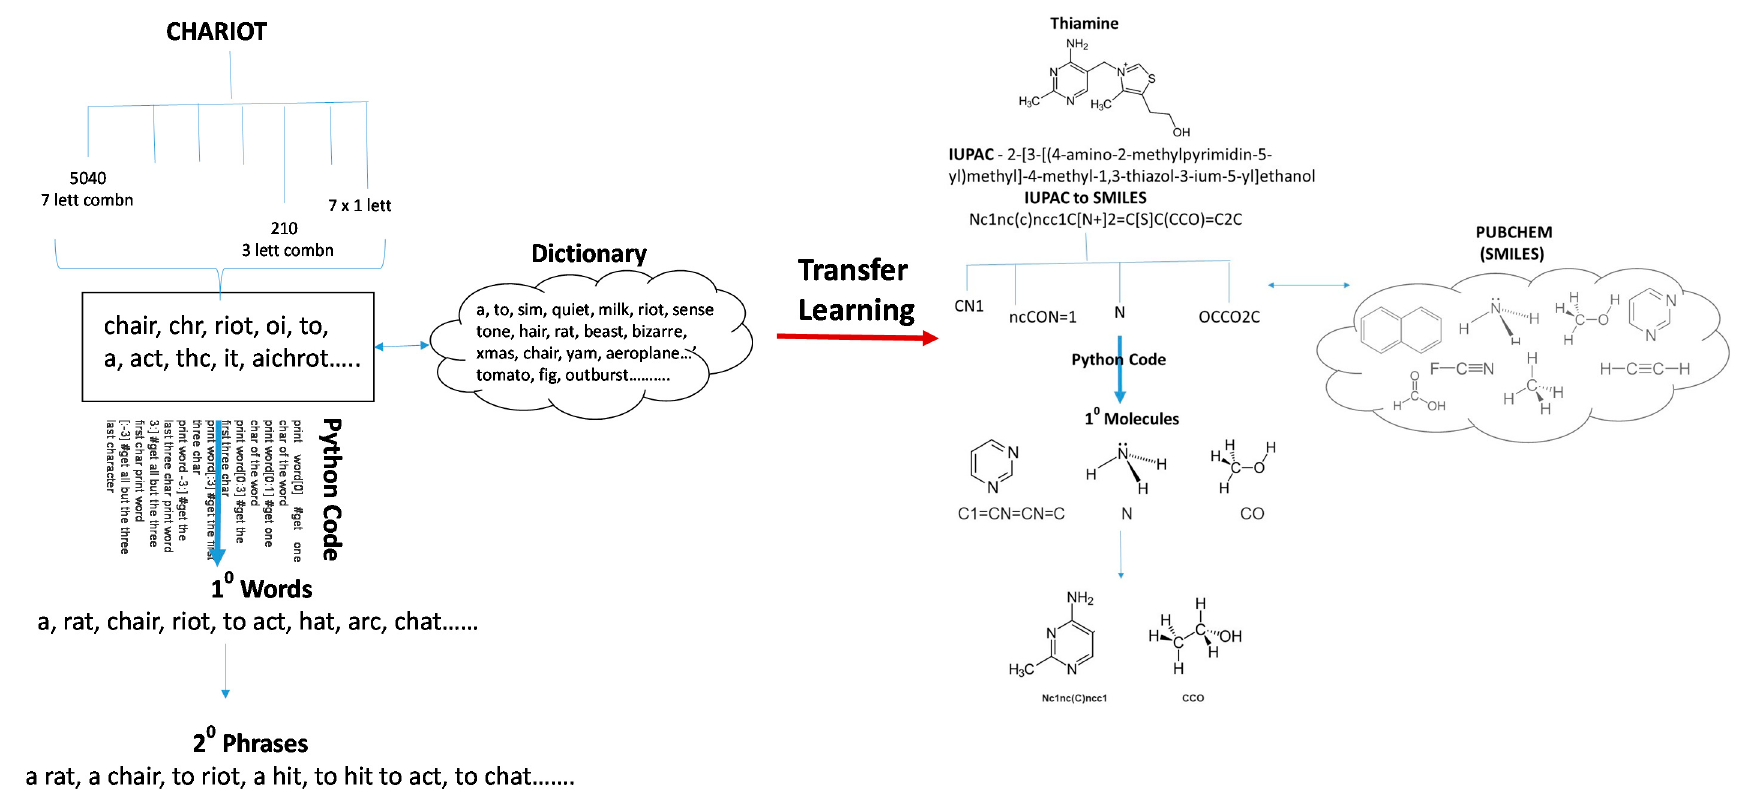
Figure 5. Transfer learning in medicinal chemistry. In this hypothetical example, an algorithm used to construct words from the English language character string CHARIOT, and subsequently phrases using those words, has been repurposed to compose small molecules from thiamine and then build larger molecules from those smaller molecules. These molecules could represent novel drug-like candidates or even metabolites of thiamine.